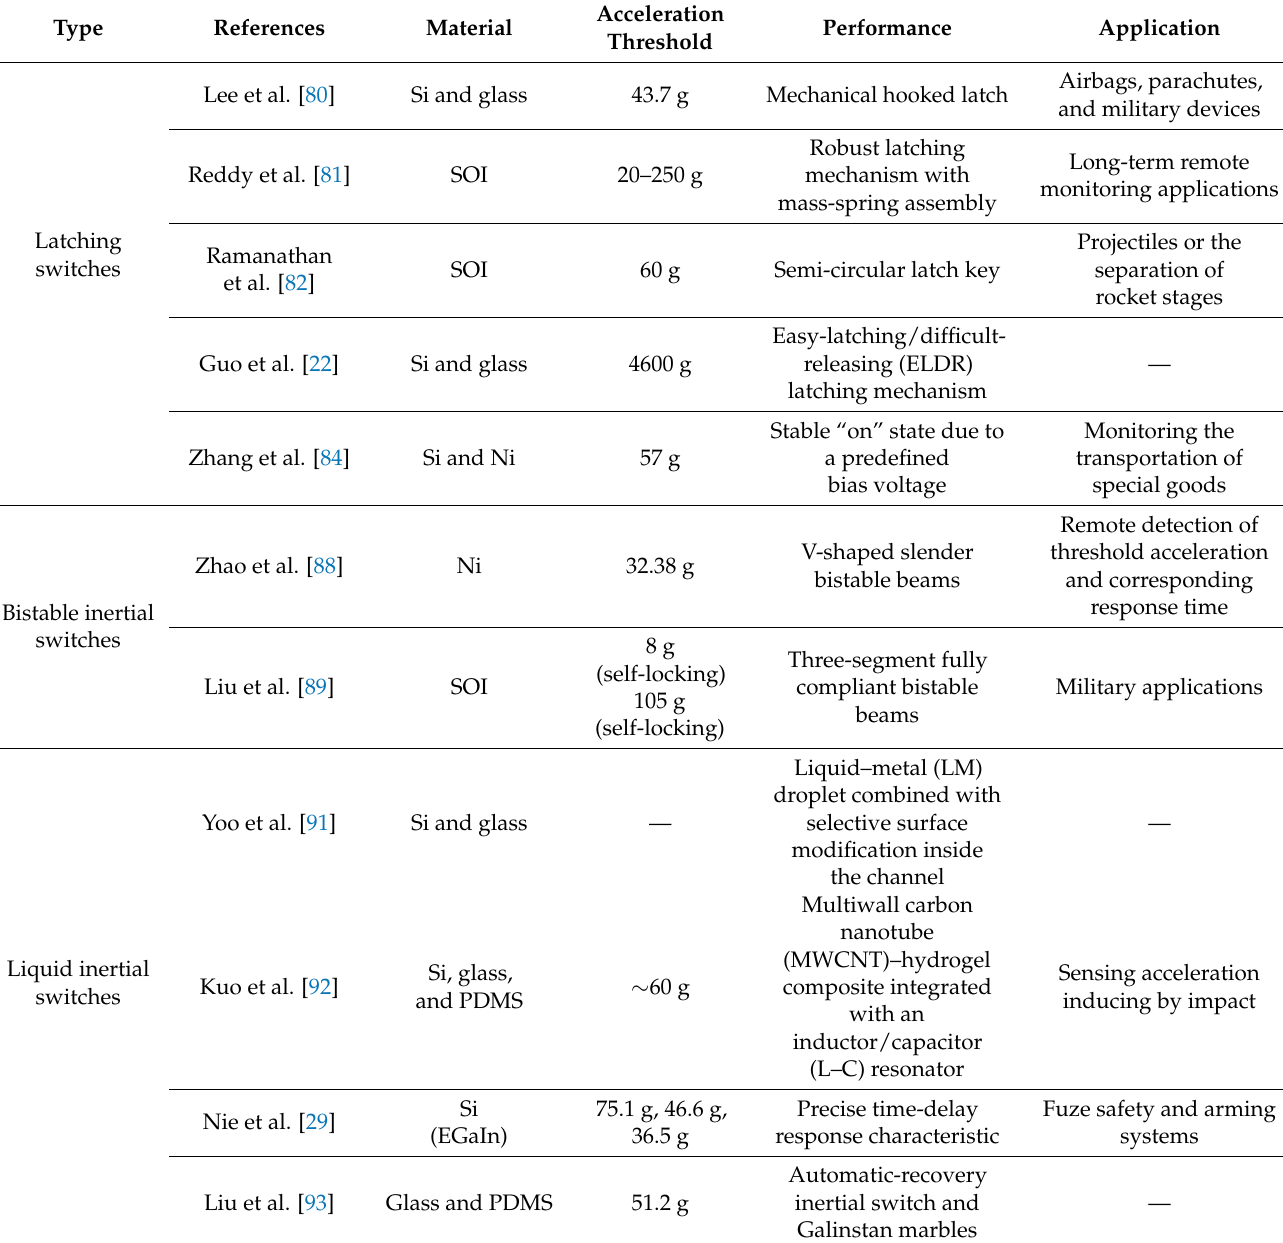
Table 6. A summary of some examples of typical persistent inertial switch